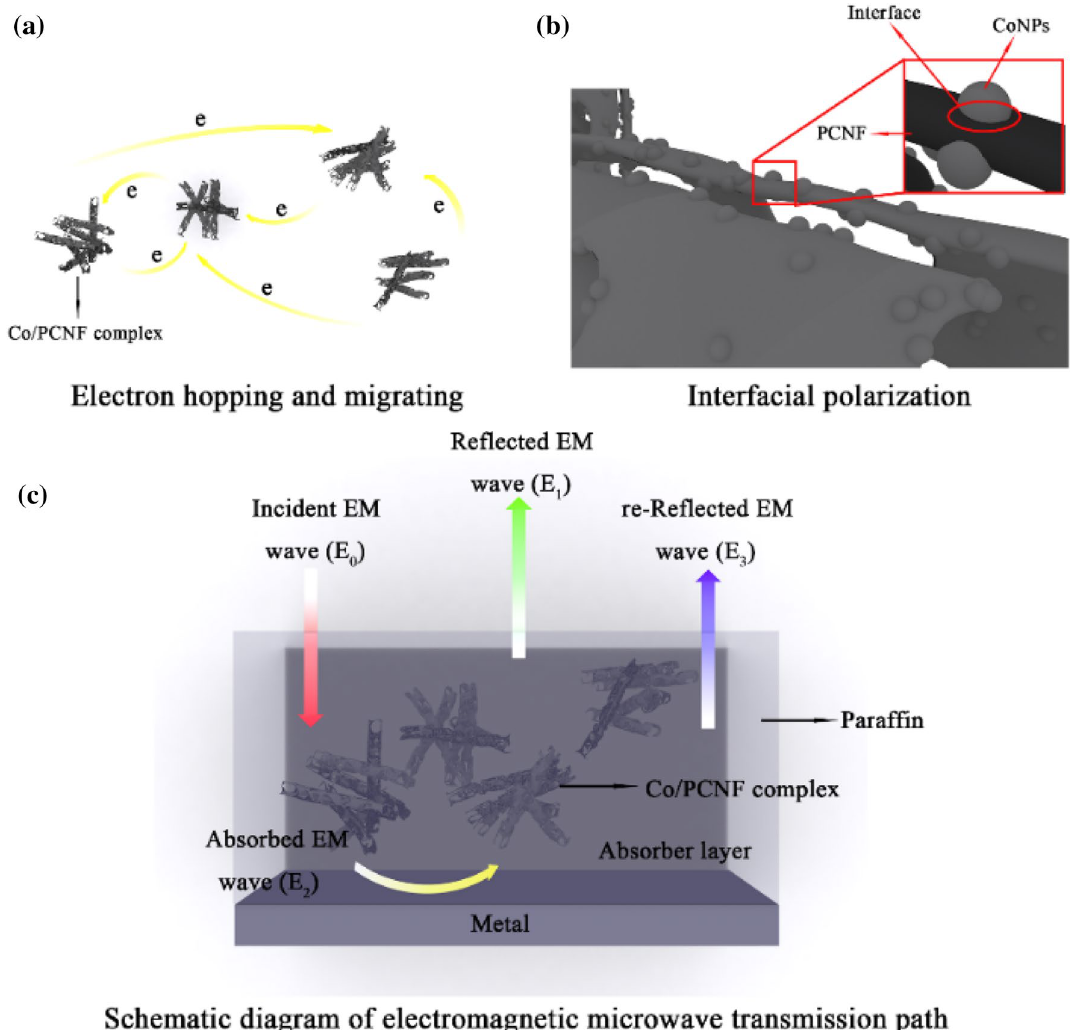
Figure 10. The illustration for main microwave attenuation mechanisms. ( a ) Hopping and migrating of free electrons under an electromagnetic field, ( b ) Interface polarization at the interface of CoNPs and PCNF, ( c ) EM transmission path.